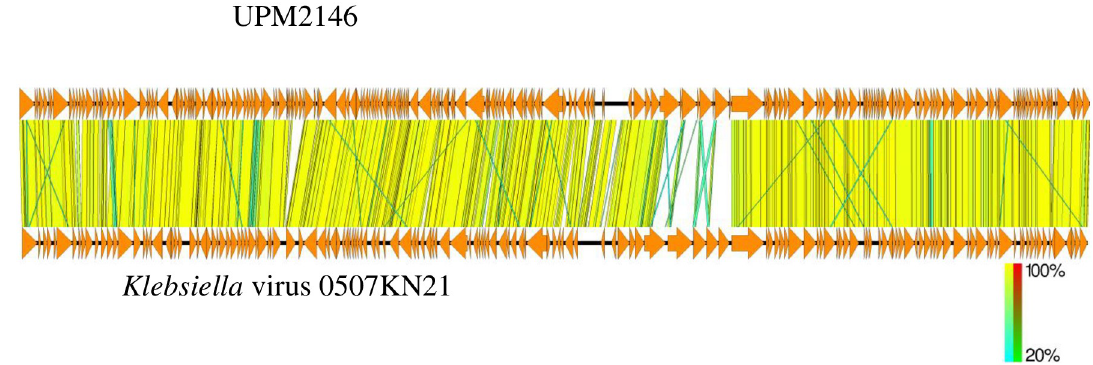
Fig 7. Genomic comparison between UPM2146 and Klebsiella virus 0507KN21 analysed using Easyfig. Genomes of each phage is represented by linear visualization of their coding sequences (CDS) represented by arrows. The direction of the arrows indicates the direction of transcription of each CDS. The black vertical lines between the two genomic sequences indicate regions of shared similarities (89%) according to BLASTn. The intensity of these lines indicates the degree of similarity. This confirms that UPM2146 belongs to Ackermannviridae